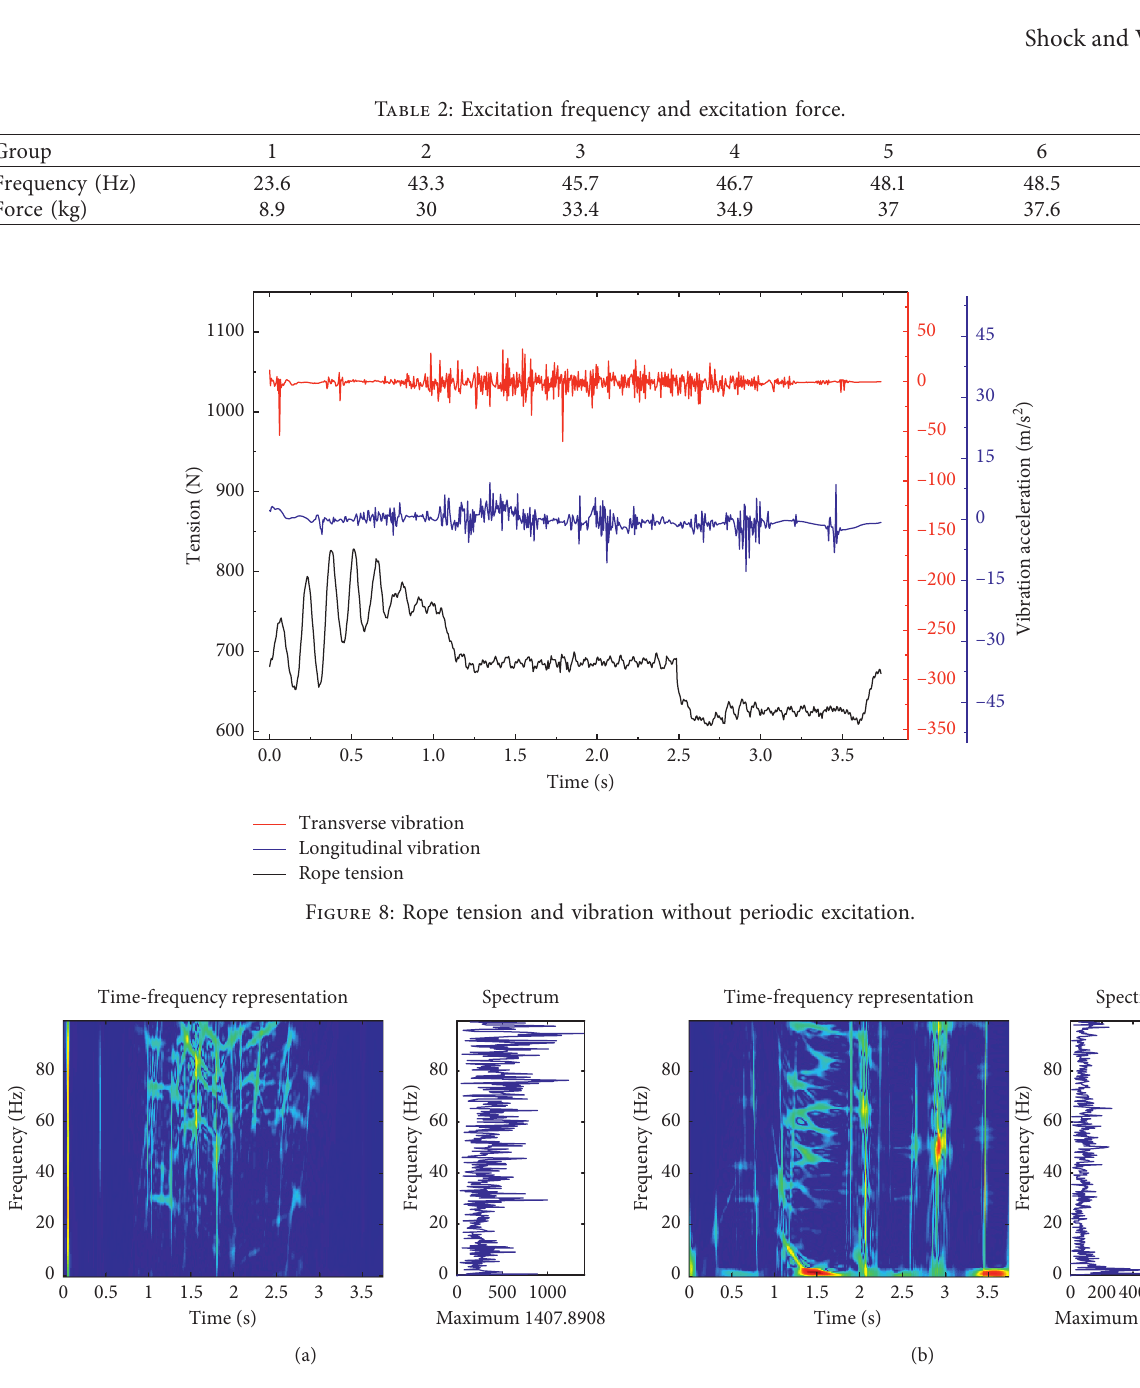
Figure 9: Time-frequency distribution of the rope vibration without periodic excitation. (a) Transverse. (b)